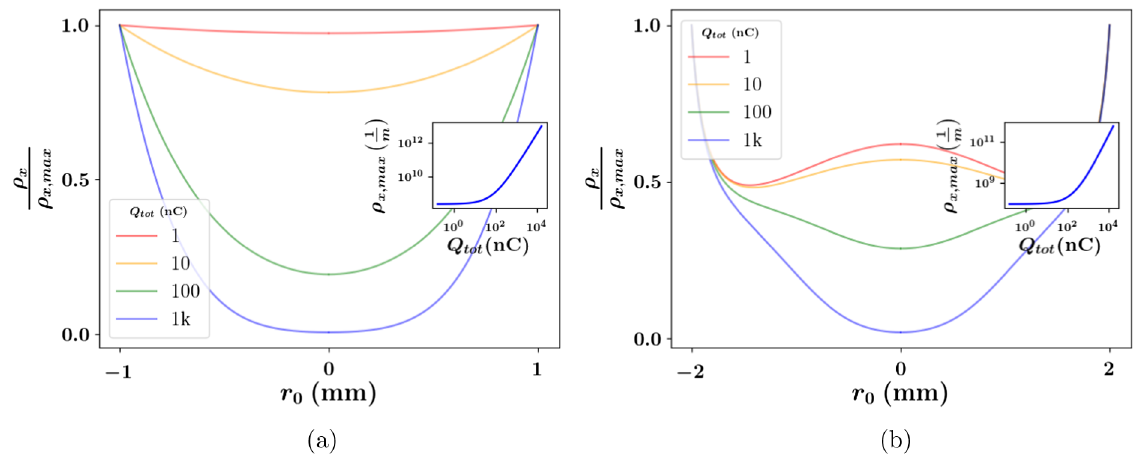
FIG. 9. The shape of ρ x 3 for various values of Q in (a) an initially uniform distribution with radius of 1 mm and (b) an initially ρ tot ; 3 x 3 ;max Gaussian distribution with standard deviation of 1 mm as a function of the initial radial coordinate. This, as well as the inset figure describing the growth of the maximum value of ρ , show the onset of the relativistic regime corresponding to roughly 24 C x 3 graph also shows that the peaks sharpen as the density increases. For the Gaussian case, this distribution diverges near r 0 ¼ 2 . This divergence is an indication that the laminar fluid assumption is being violated, and therefore the nonuniform asymptote for ρ taken as a gross approximation; nonetheless, the expression derived in the text do capture the shape of freely-expanding relativistic Gaussian distribution in the simulation presented in Fig.